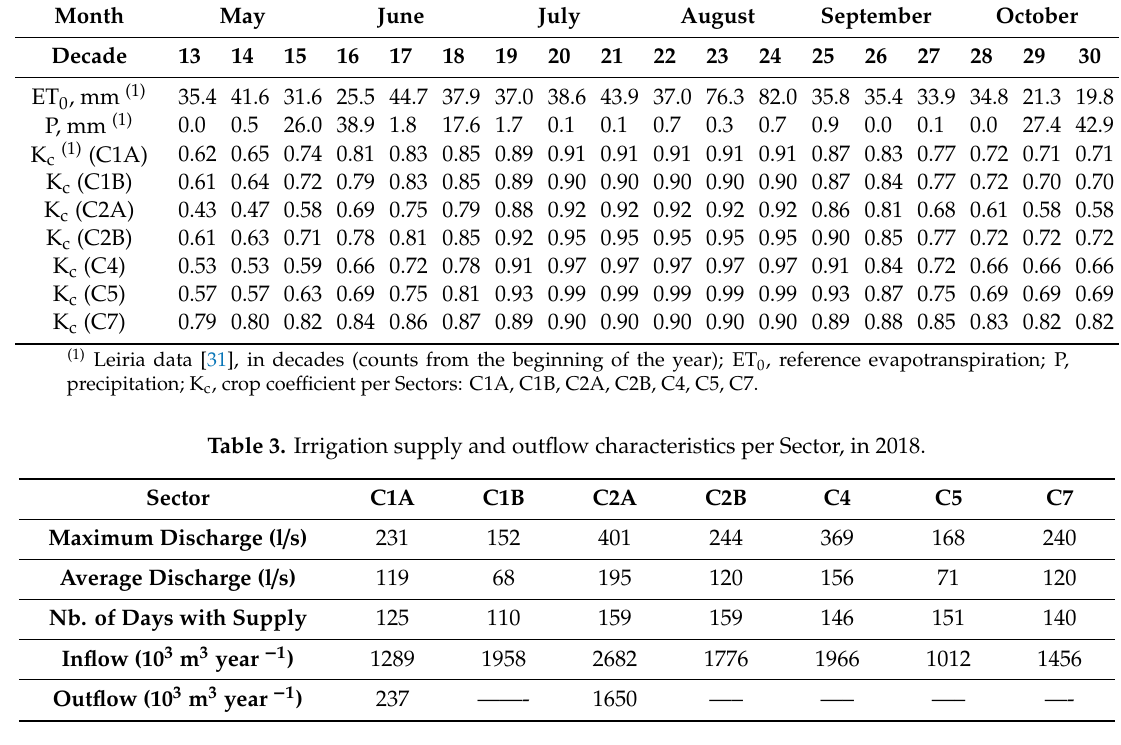
Table 2. Meteorological data and average crop coe ffi cients per Sector, in 2018.